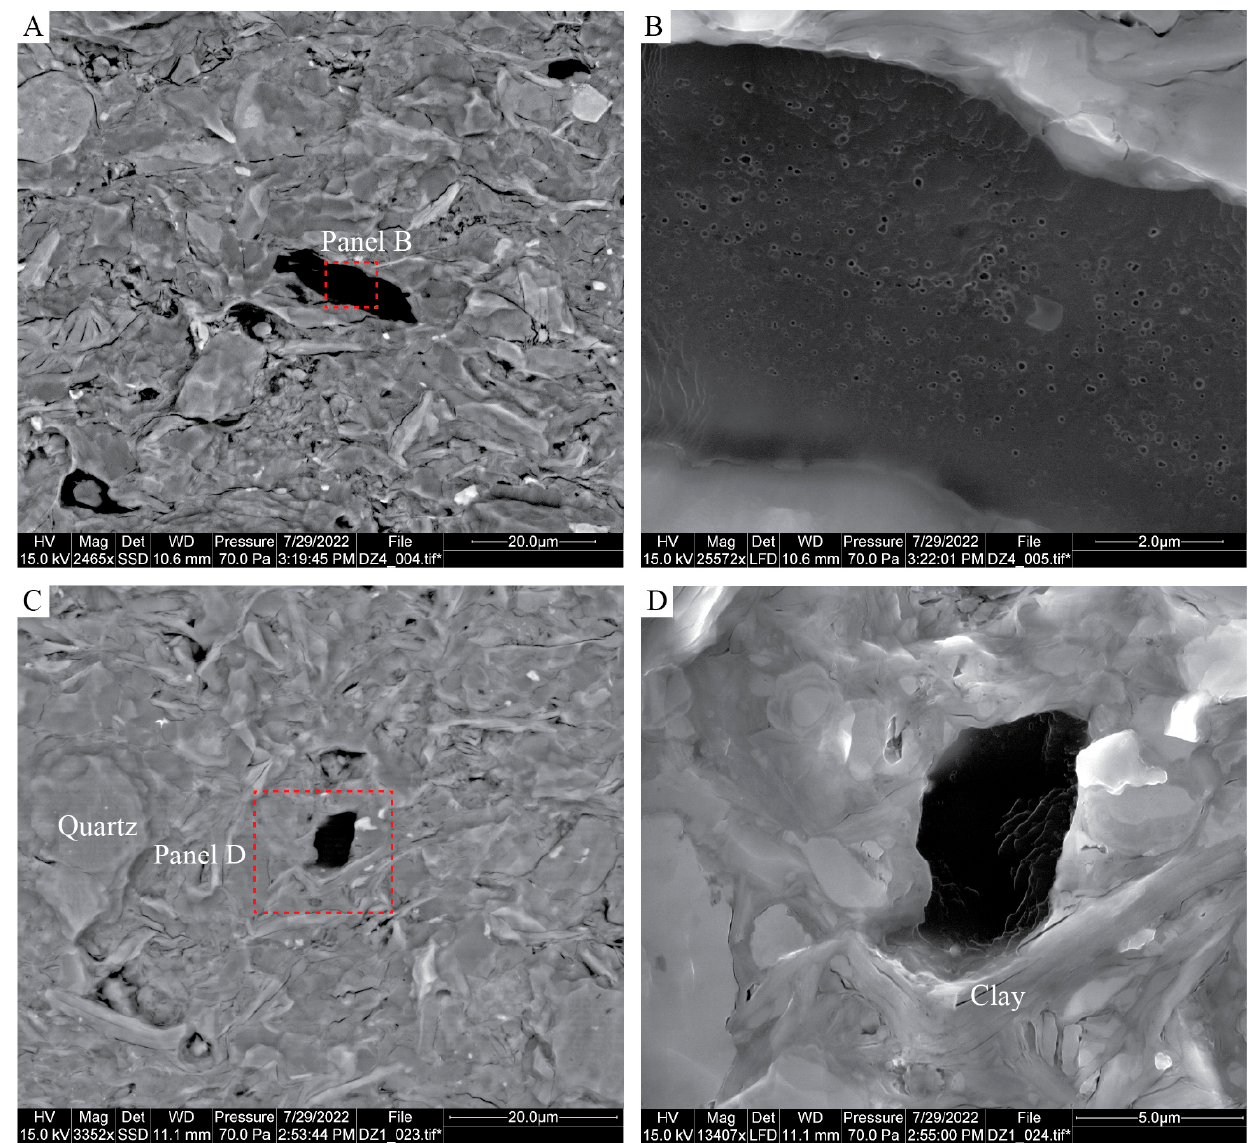
Figure 6. SEM images of terrigenous organic matter. ( A , B ) Inertinite with cellular pores, sample DZ-4. ( C , D ) Terrigenous organic matter without pores, sample DZ-1. Panels ( C , D ) are the enlarged views of the red dashed areas in panels ( A , C ), respectively.